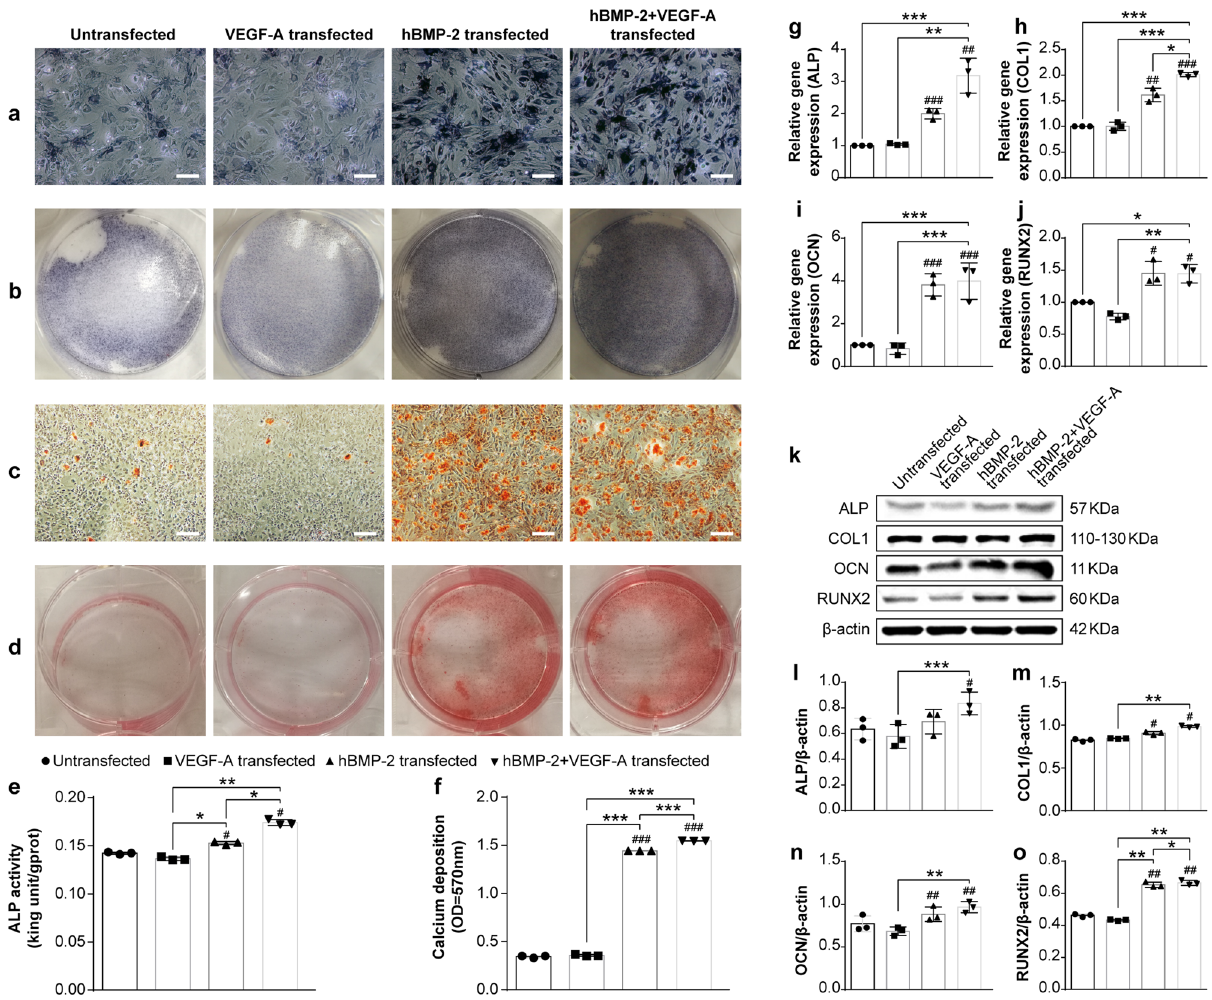
Fig. 2 Molecular and cellular detection of in vitro osteogenesis following modRNA transfection in BMSCs. a Alkaline phosphatase (ALP) staining of BMSCs at 7 days post-transfection in different modRNA treatment groups. The scale bars represent 125 μ m. b Gross appearance of ALP staining. c Detection of mineralized matrix using alizarin red staining 14 days post-transfection in indicated modRNA treatment groups. d Gross appearance of alizarin red staining 14 days post transfection. The scale bars represent 250 μ m. e , f Quanti fi cation of ALP activity ( e ) 7 days post-transfection and quanti fi cation of alizarin red staining ( f ) 14 days post-transfection. Signi fi cant differences between untreated and modRNA-transfected cells are indicated by (* p < 0.05, ** p < 0.01, *** p < 0.001). N = 6, one-way ANOVA test. g – j Fold increase in gene expression of ( g ) ALP, ( h ) Collagen Type I (COL 1), ( i ) Osteocalcin (OCN), and ( j ) Runt-related transcription factor 2 (RUNX2) at 7 days post-transfection determined by qRT-PCR analysis. k – o Representative western blot assessment ( k ) and quanti fi cation of protein expression of ALP ( l ), COL1 ( m ), OCN ( n ), and RUNX2 ( o ) following transfection of indicated modRNA treatments. Hash (#) indicate difference between non-transfection and transfection groups. Astersisk (*) indicate difference among different modRNA transfection groups. Results are normalized to the housekeeping gene (rat β -actin) and to the untreated cells. Values are shown as mean ± SD, #/ * p < 0.05, ##/ ** p < 0.01, ###/ *** p < 0.001. N = 6, One-way ANOVA followed by Tukey ’ s multiple